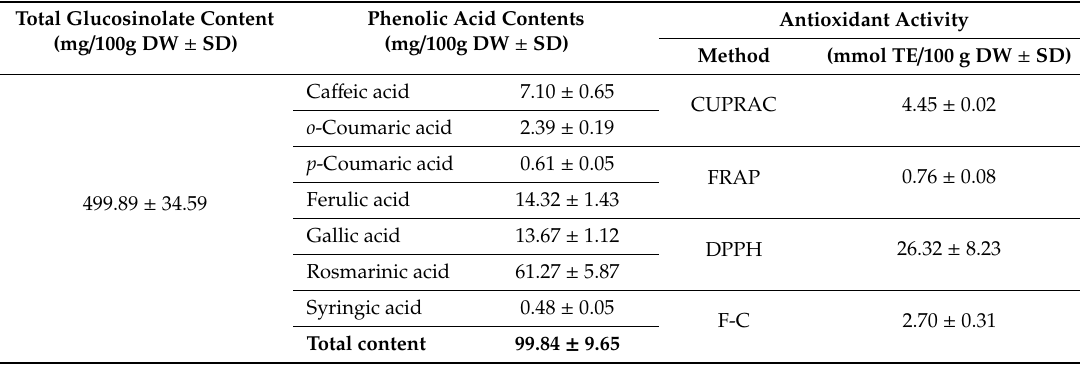
Table 5. The contents (mg / 100 g DW ± SD) of total glucosinolates and individual and total phenolic acids, antioxidant activity estimated by CUPRAC, FRAP, DPPH methods and total phenolics F-C method (expressed as TE in mmol / 100 g DW ± SD) in the extracts from parent plant